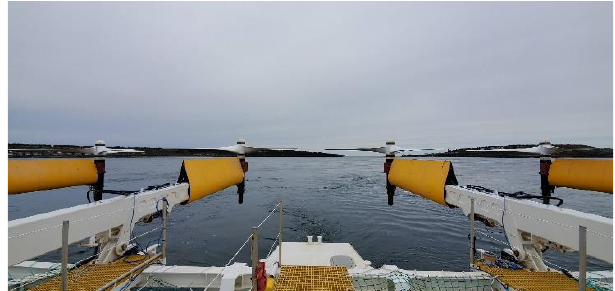
Fig. 5 SIT turbine rotors with “clean” blades